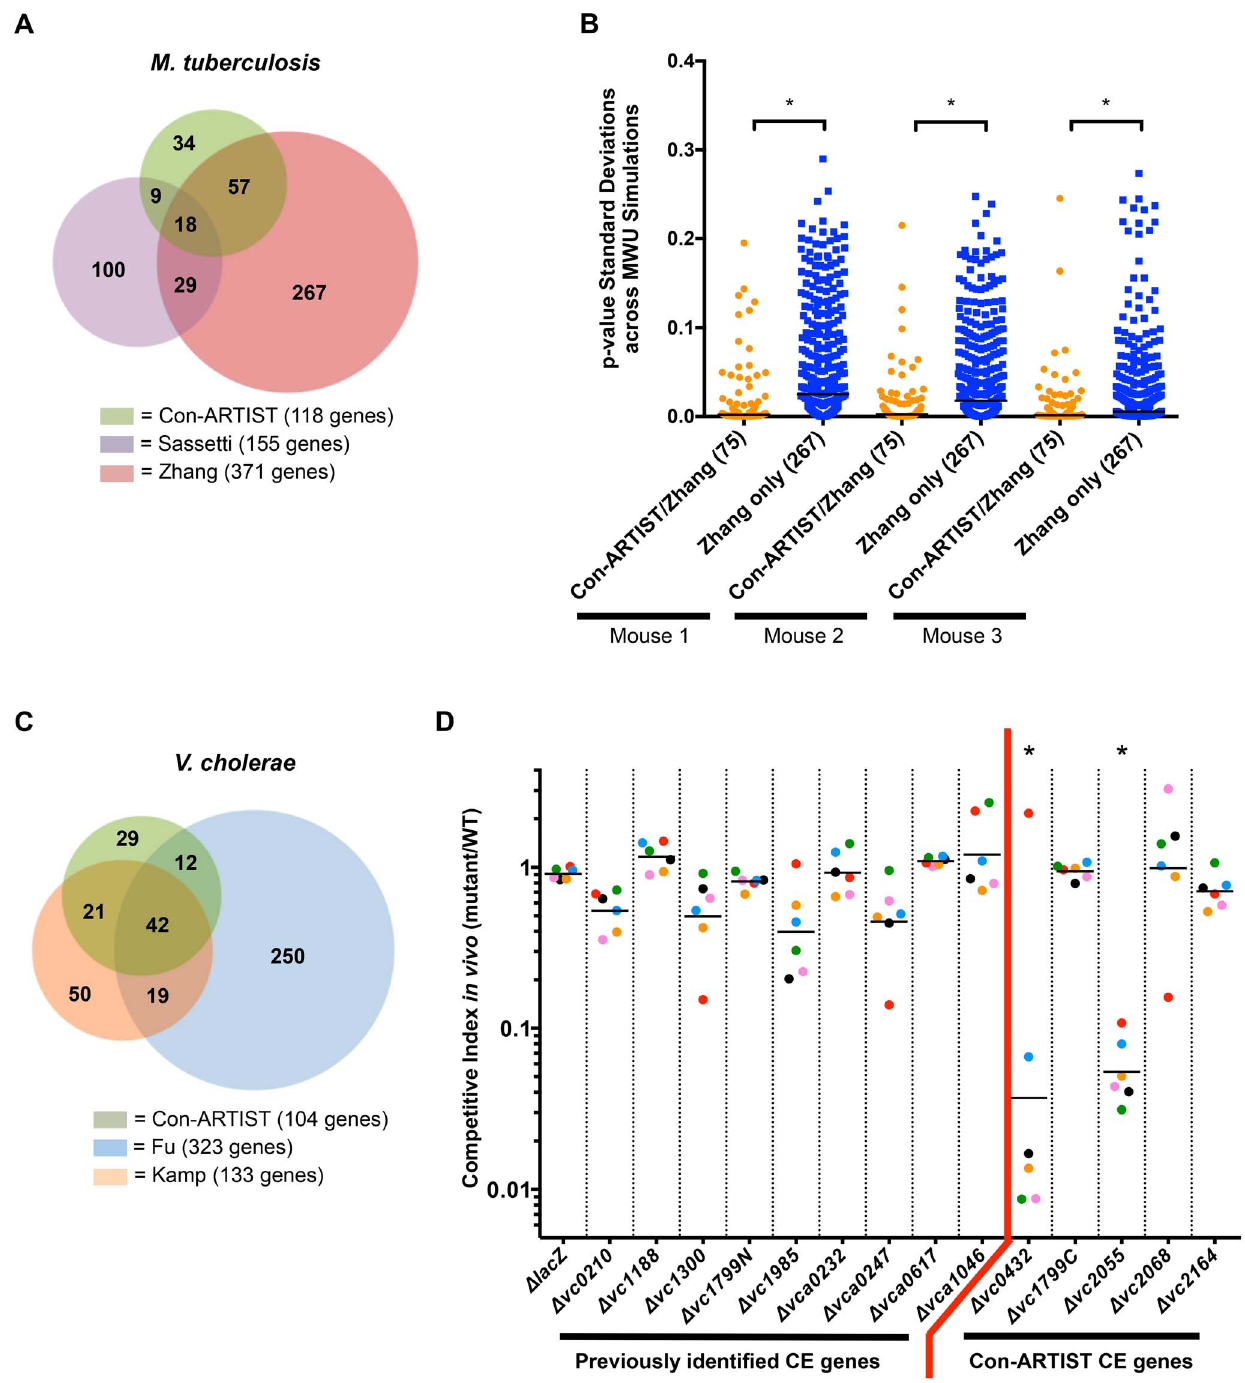
Figure 4. Con-ARTIST improves detection of conditionally essential genes compared to previous studies. (A) Overlap of the conditionally essential genes in M. tuberculosis required for mouse infection as determined by Con-ARTIST, Sassetti et al. [15] and Zhang et al. [7]. The overlap between Con-ARTIST and Sassetti et al. was significantly better than the overlap between Zhang et al. and Sassetti et al. (p-val , 0.05, one- tailed Fisher’s exact test). (B) The standard deviations of p-values across 100 simulation-based MWU tests were plotted for either Con-ARTIST conditionally essential genes in M. tuberculosis that overlap with Zhang et al. (75 genes), or for genes that were significant only in the Zhang et al. dataset (267 genes). In all three mice, genes that overlap between Con-ARTIST and Zhang et al. had significantly (*, p-value , 0.0005) narrower ranges of p-value standard deviations across MWU tests than genes categorized as conditionally essential only by Zhang et al. (C) Overlap of conditionally essential genes required for V. cholerae rabbit infection as defined by Con-ARTIST, Kamp et al. [16] or Fu et al. [11]. Genes that were defined as defective for in vitro growth by Kamp et al. were filtered from both the Con-ARTIST and Fu et al. results. The overlap between Con-ARTIST and Kamp et al. was significantly higher than the overlap between Kamp et al. and Fu et al. (p-value , 0.0001 by one-tailed Fisher’s exact test). (D) In-frame deletions were constructed in several V. cholerae genes that were either identified as required for rabbit infection in previous studies (but not by Con- ARTIST) or unique predicted to be conditionally essential (CE) in this study. WT and mutant cells were first barcoded and then pooled to infect rabbits.